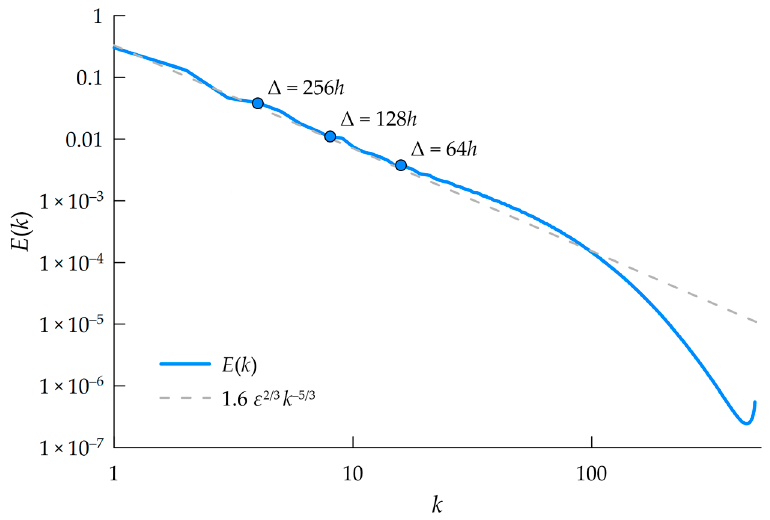
Figure 1. Radial kinetic energy spectrum in DNS and different filter cut-off scales.